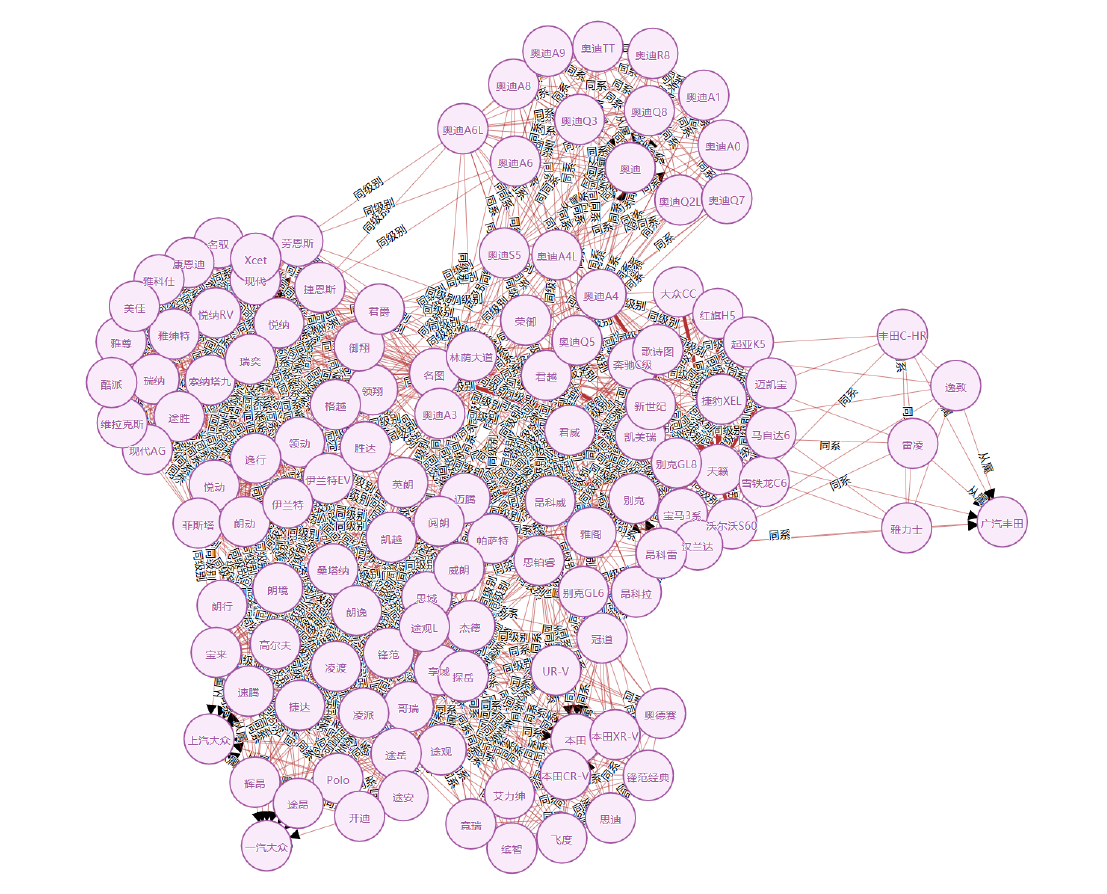
Figure 20. knowledge graph of the